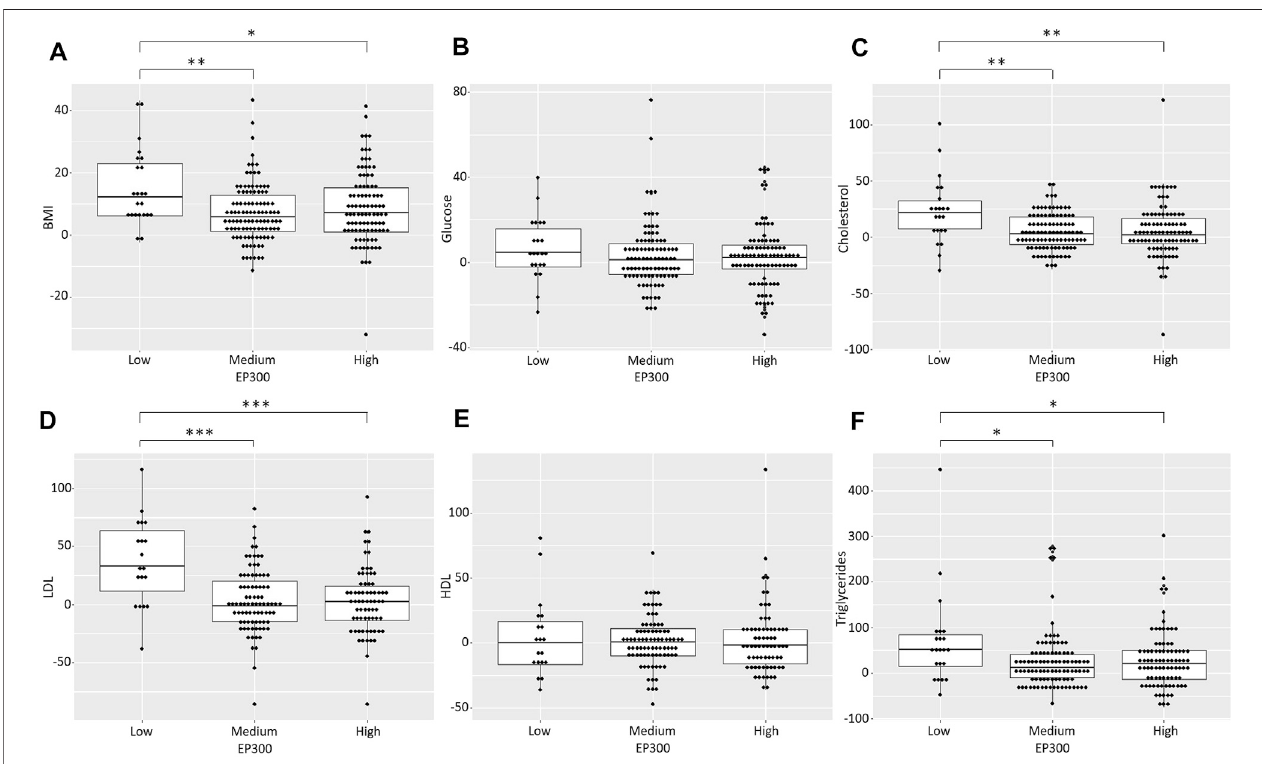
FIGURE4| Explorationof EP300 asakeygeneinantipsychotic-inducedmetabolicdysregulationinpatientswithFEPreceivingsecond-generationantipsychotics. Scatterboxplotsoftheincreasesintheanthropometricand metabolictraits assessed accordingtothepredicted EP300 expressionlevels usingtheprediction modelof the liver, the adipose tissue and the small intestine. * p < 0.05; ** p < 0.01; *** p < 0.001.